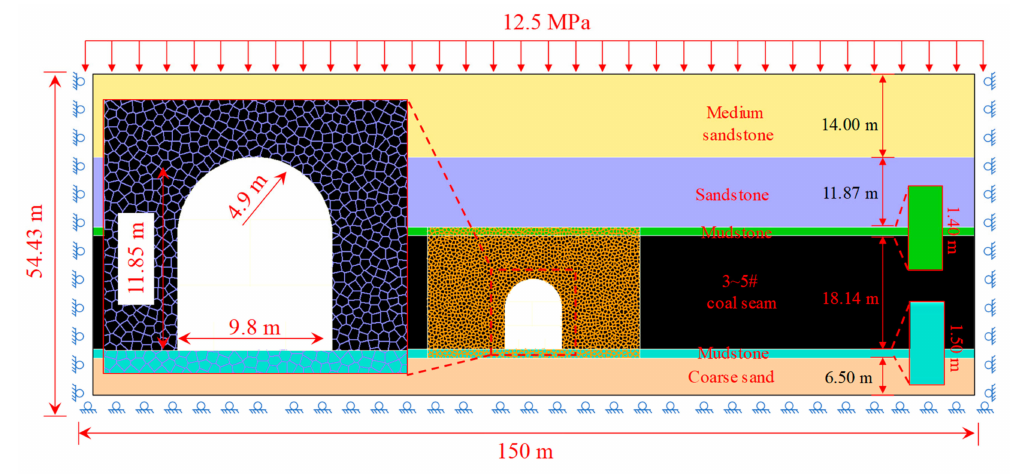
Figure 10. Numerical